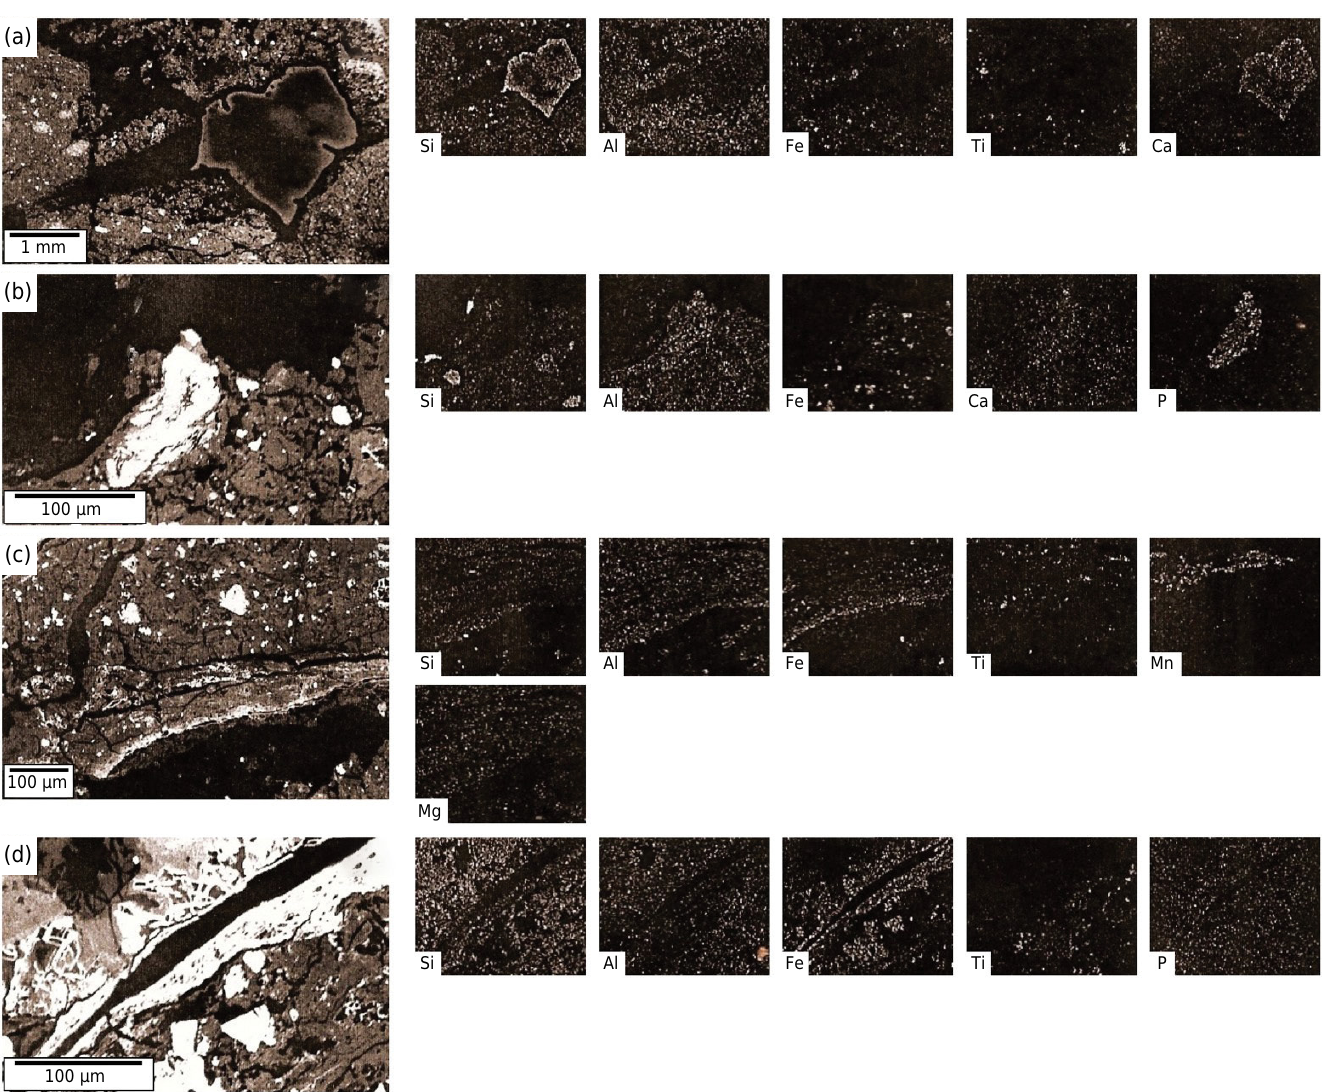
Figure 10. Scanning electron microscope photomicrographs and EDS microchemical maps of the Bi horizon in the P 6 - Eutric Chromic Petroplintic Leptic Cambisol (Clayic, Humic); Coromandel topolithosequence. Volcanic glass rich in Si and Ca (a), apatite grains partially weathered (b), and illuvial coatings (ferrans and mangans) (c and